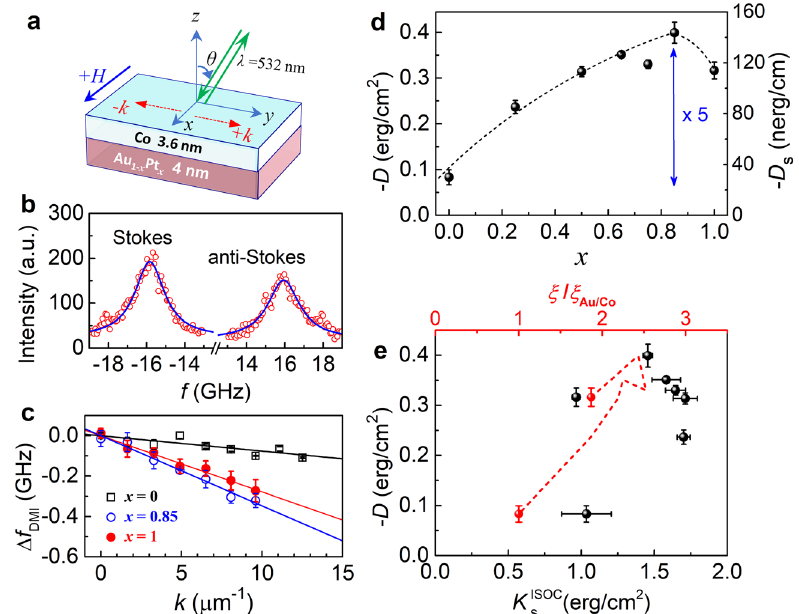
Fig. 2 Interfacial Dzyaloshinskii-Moriya interaction (DMI). a Brillouin light scattering measurement geometry; b Brillouin light scattering spectrum (wave- vector k = 8.1 μ m − 1 , magnetic fi eld H = 1700 Oe, Pt concentration x = 0.85), c k dependence of Δ f DMI ( x = 0, 0.85, and 1), d The volumetric DMI constant D , the total DMI constant D D for Au x plotted as a function of interfacial magnetic anisotropy energy s , and e 1 − x Pt x 4 nm/Co 3.6 nm bilayers with different density K ISOC (black) and the strength of interfacial spin-orbit coupling ξ (red). In ( b ) the blue solid curves represent fi ts to the Lorentzian function. In ( c ) s the solid lines refer to the best linear fi ts. In ( d ) the blue arrow indicates a fi vefold variation of the DMI strength and the dashed line is just to guide the eyes. In ( e ) the ξ values for the red dashed line are taken from Fig. 1e. The error bars represent the standard deviation of the fi t